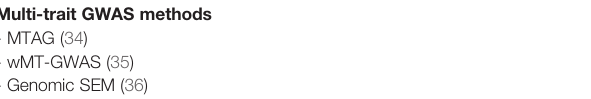
TABLE 1 | A list of polygenic risk score and other relevant methods. Multi-trait GWAS methods - MTAG